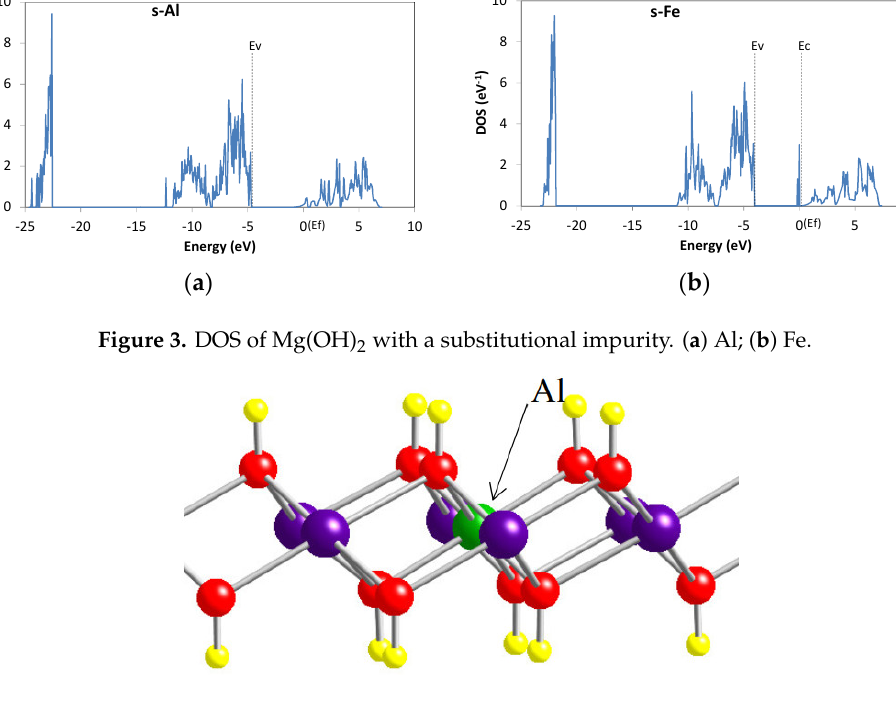
Figure 4. Atomic structure around an s-Al atom after relaxation.